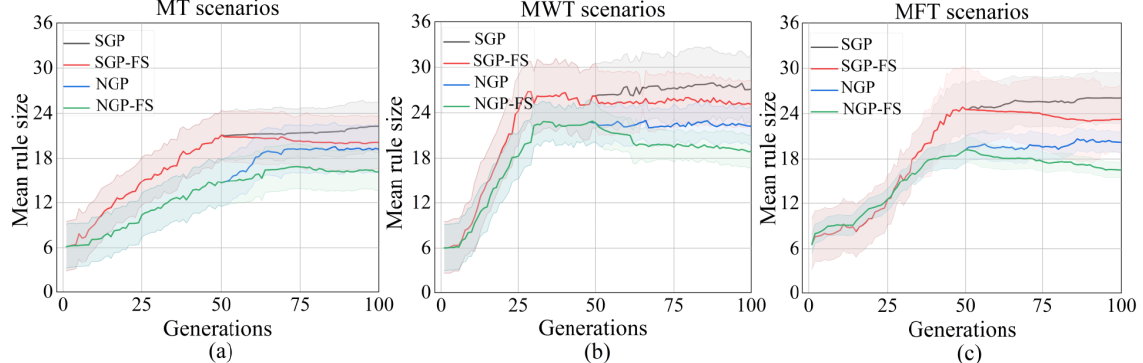
Figure 4. The average rule size of the GP algorithms for the three objectives in the training stage. (a): Mean rule size across generations for the MT scenarios, (b): Mean rule size across generations for the MWT scenarios, and (c): Mean rule size across generations for the MFT scenarios.